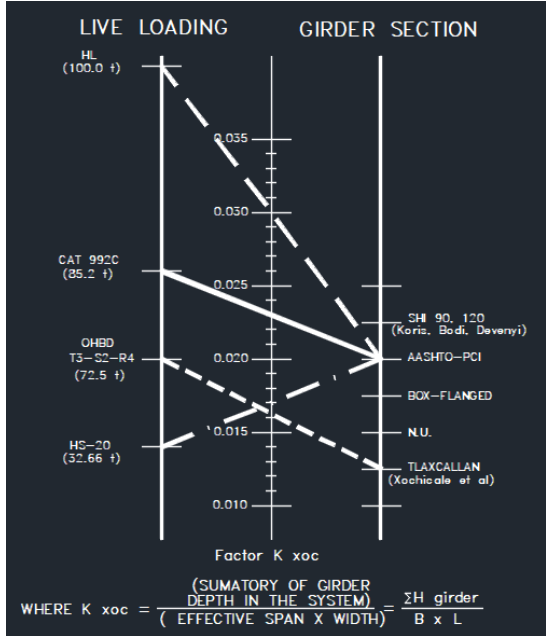
Figure 4. Graphic definition of K xoc , according to live loading and girder type.